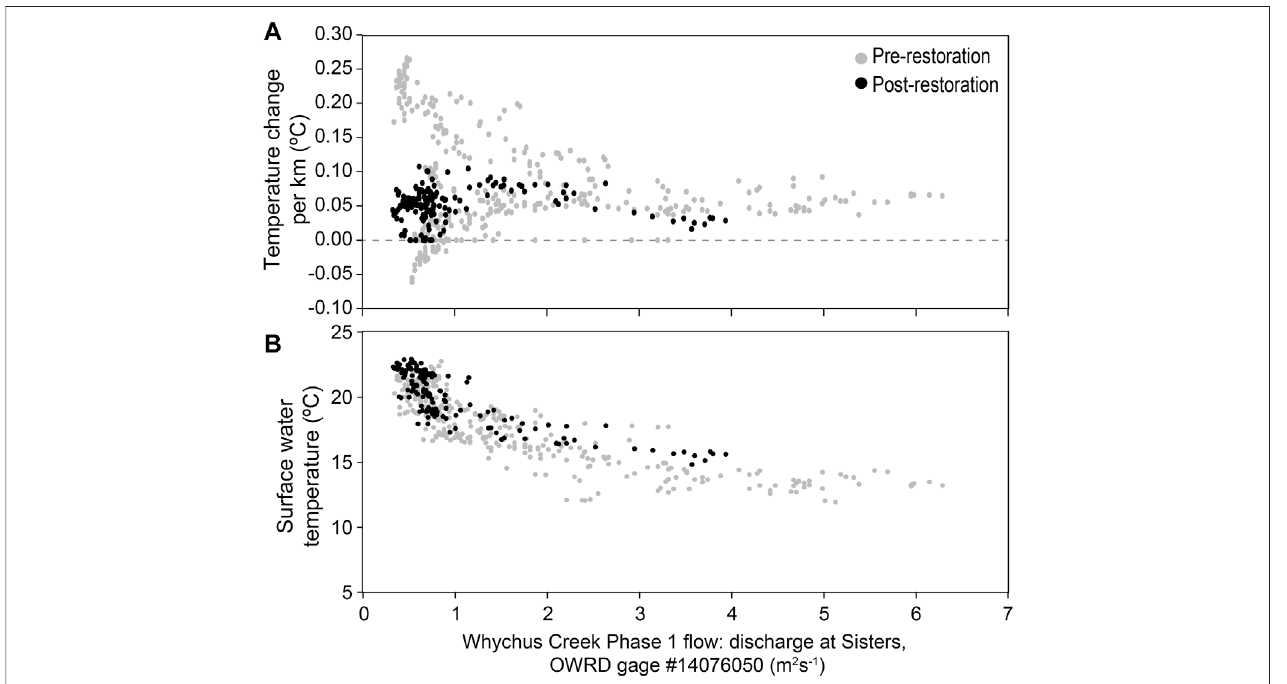
FIGURE 5 | Water temperature pre- and post-restoration to a Stage 0 condition at Whychus Creek at Whychus Canyon: (A) rate of change per kilometer, and; (B) surface temperature ( ° C).